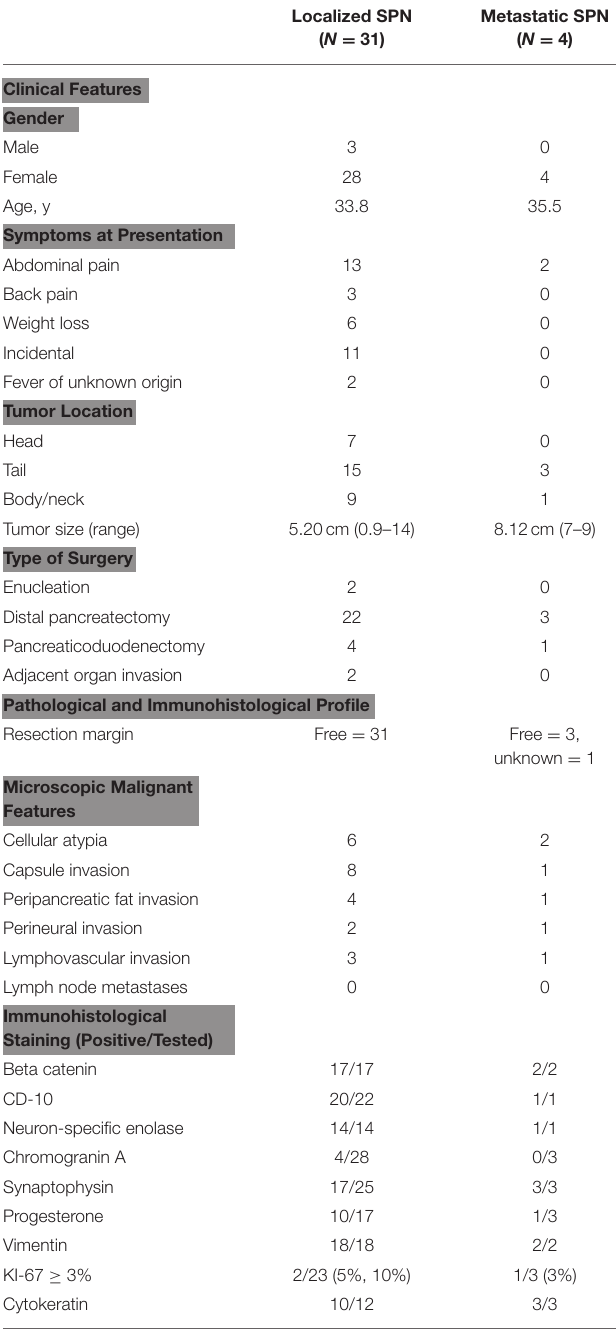
TABLE 1 | Clinical features of patients, pathological and Immunohistological profile of metastatic and localized SPNs.